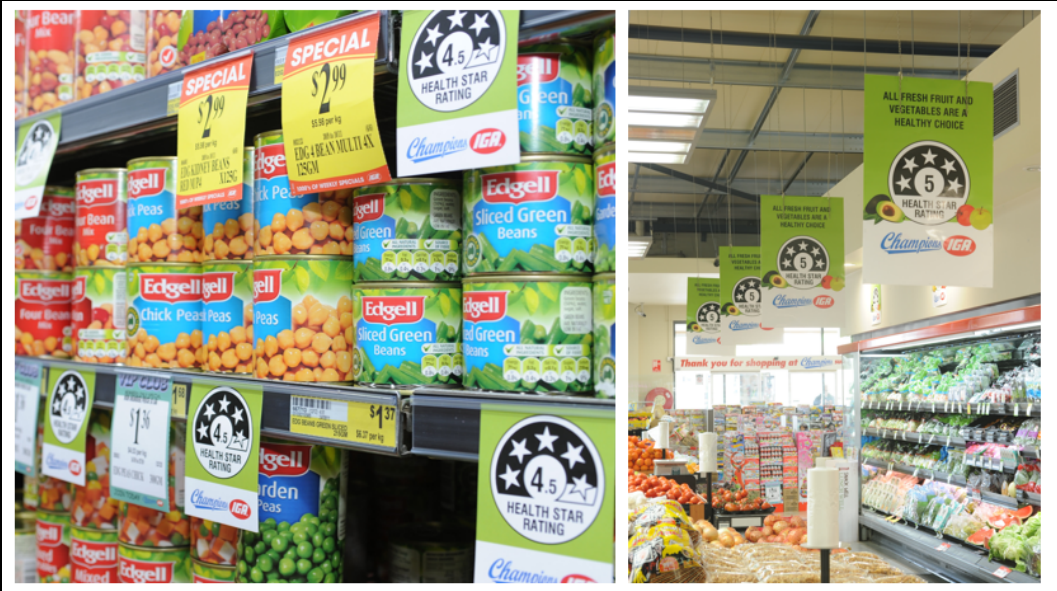
Figure 1. Example of Health Star Rating shelf tags and posters used to promote healthy eating in